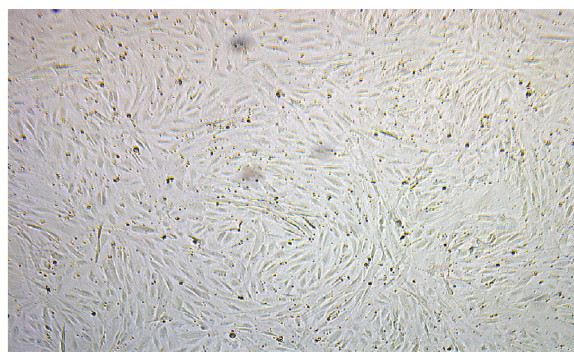
Figure 6: Growth to con fl uency of deceased donor adipose-derived MSC